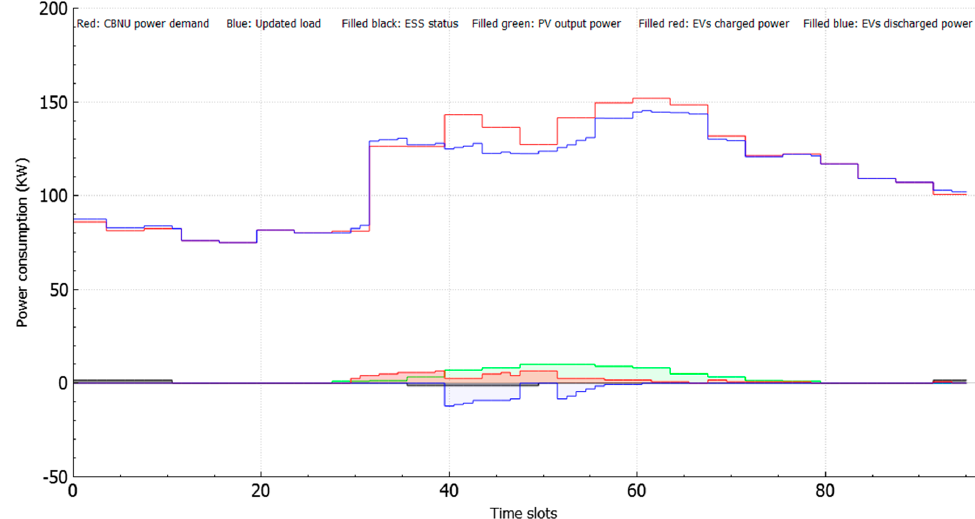
Figure 8. Results of scenario three with 50 EVs, a PV system of 10 kWh and an ESS of 30 kWh.